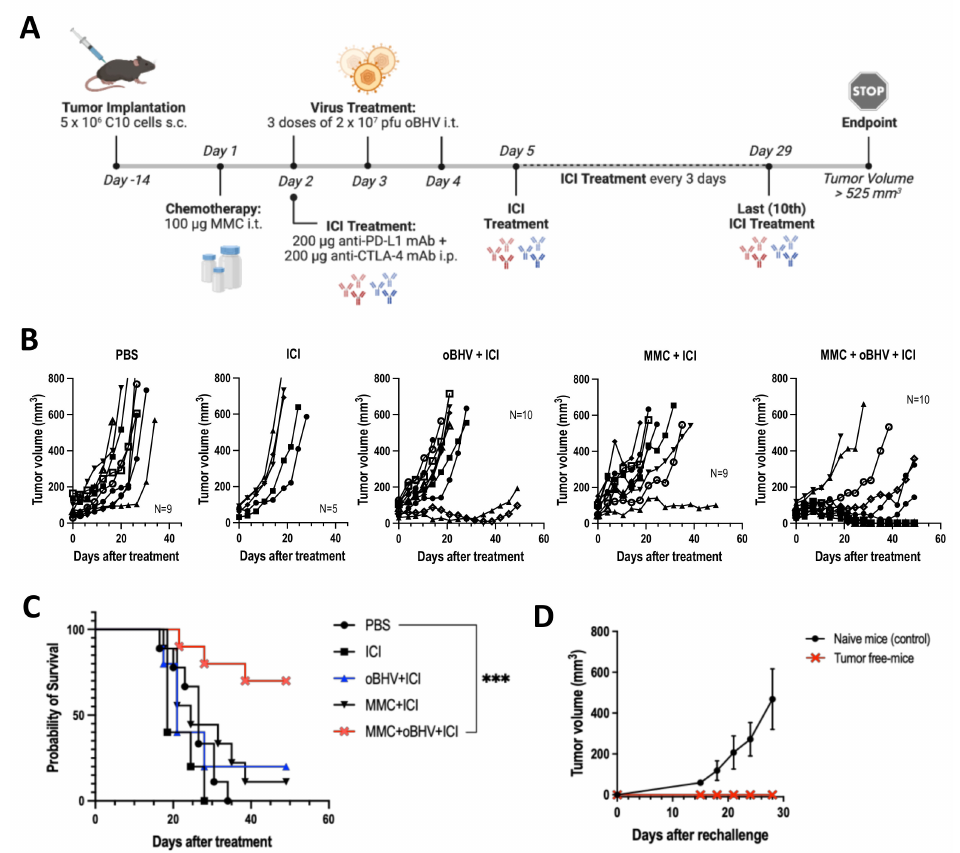
Figure 3. Tumors were treated with PBS, ICI ( α CTLA-4 & α PD-L1) or different combinations of MMC, oBHV and ICI ( A ). Tumors were measured every 3–4 days until animals reached endpoint. Tumor volume progression of each mice in each group ( B ) and Kaplan-Meier survival curve ( C ) are shown. ( D ) Tumor-free mice that completely responded to MMC + oBHV + ICI treatment and naïve mice (control) were re-challenged by B16-C10 implantation. Tumors were measured every 3–4 days for 4 weeks. Tumor volume mean ± SEM is shown ( D ). *** p <